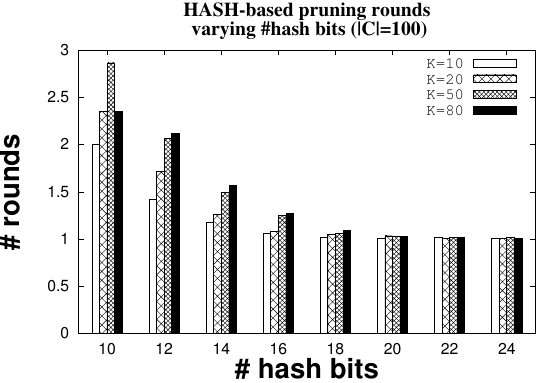
Figure 8. Number of rounds to remove FPs with varying hash length.